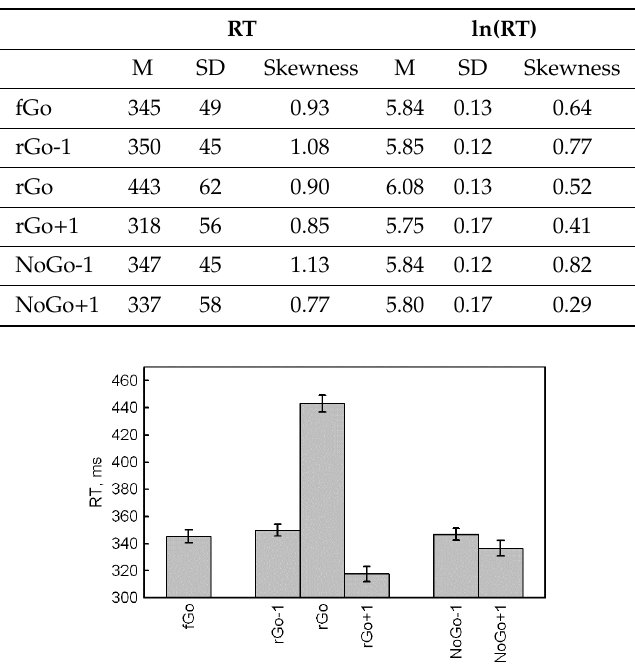
Figure 1. Reaction times for rare Go and subcategories of frequent Go stimuli.